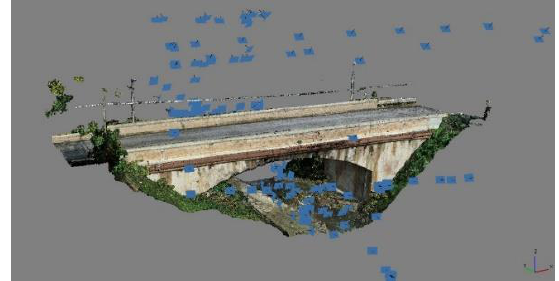
Figure 11. Photogrammetric model reconstructed with images collected during the UAV-LiDAR survey.